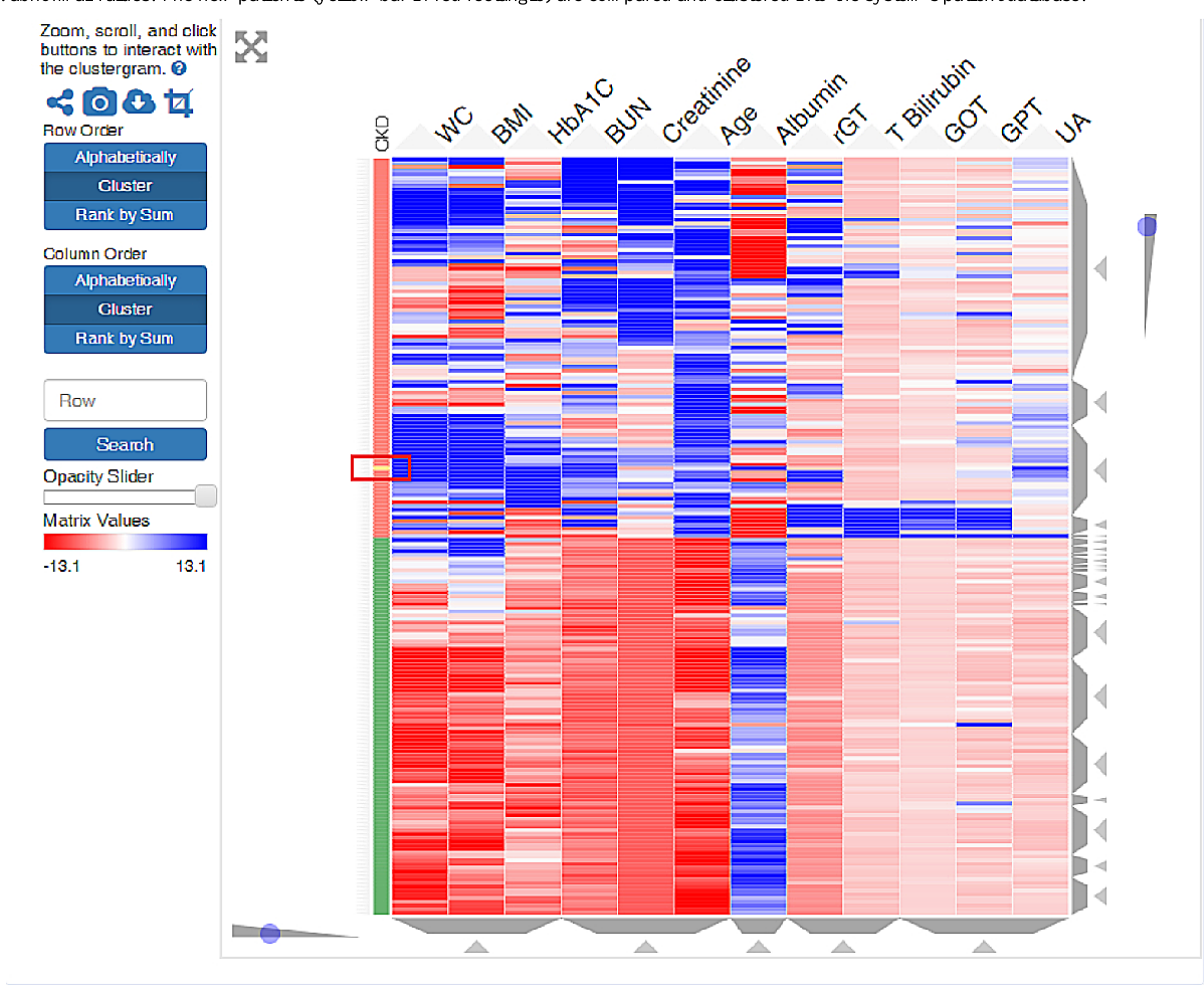
Figure 6. Dynamic interactive heat map obtained using unsupervised clustering. Green: healthy patients; orange: CKD patients; blue: normal values; red: abnormal values. The new patients (yellow bar in red rectangle) are compared and clustered into the system’s patient